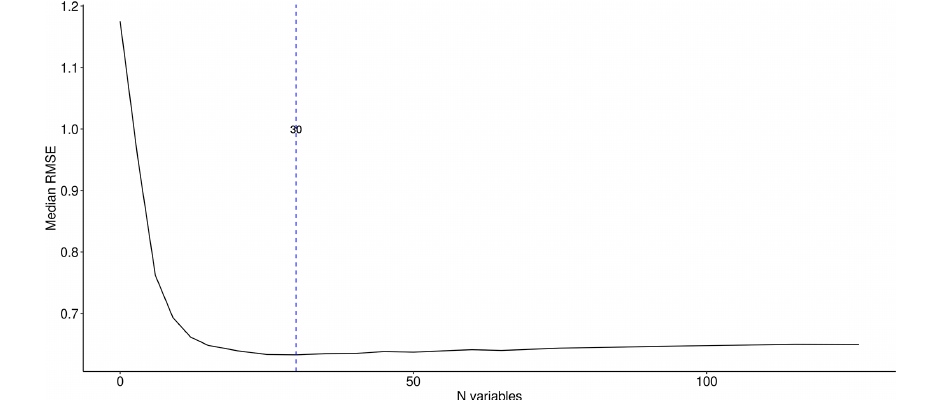
Figure 5. Example of loss function (RMSE) used in the RFE step of covariates’ selection.